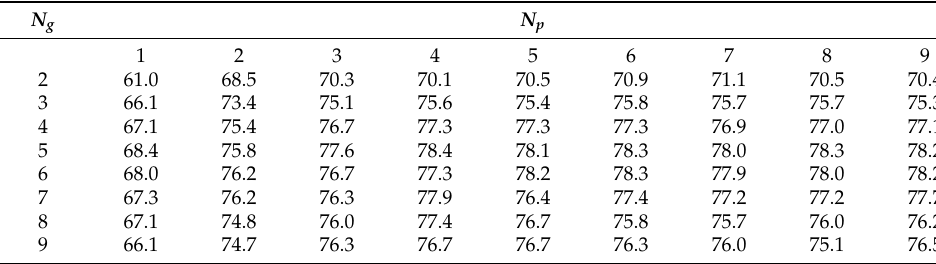
Table 2. Percentages of data sets with R Mod ≥ 0.7.